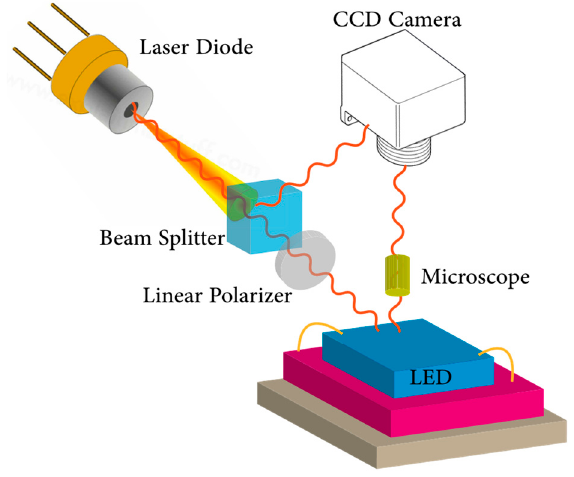
Figure 8. A schematic of a typical measurement arrangement and experimental apparatus used for the Raman spectroscopy setup.